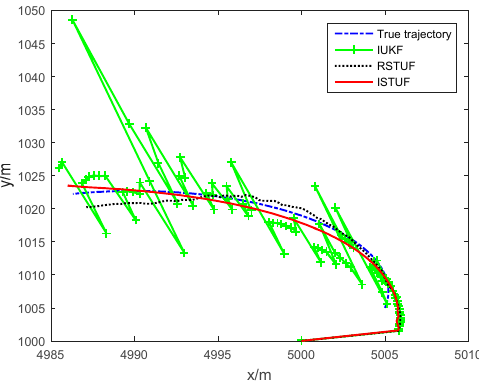
Figure 1. Comparison of the trajectories.